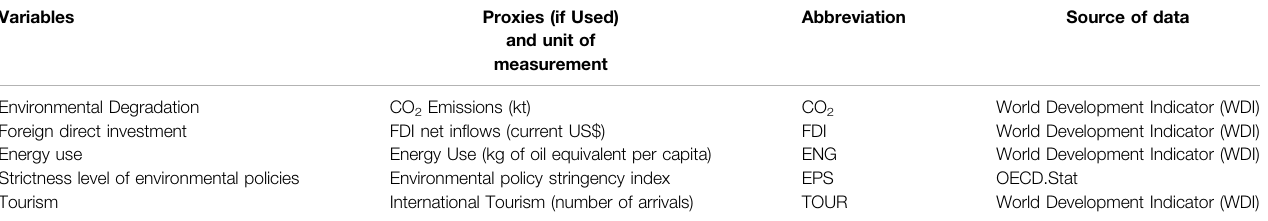
TABLE 1 | Description of variables.